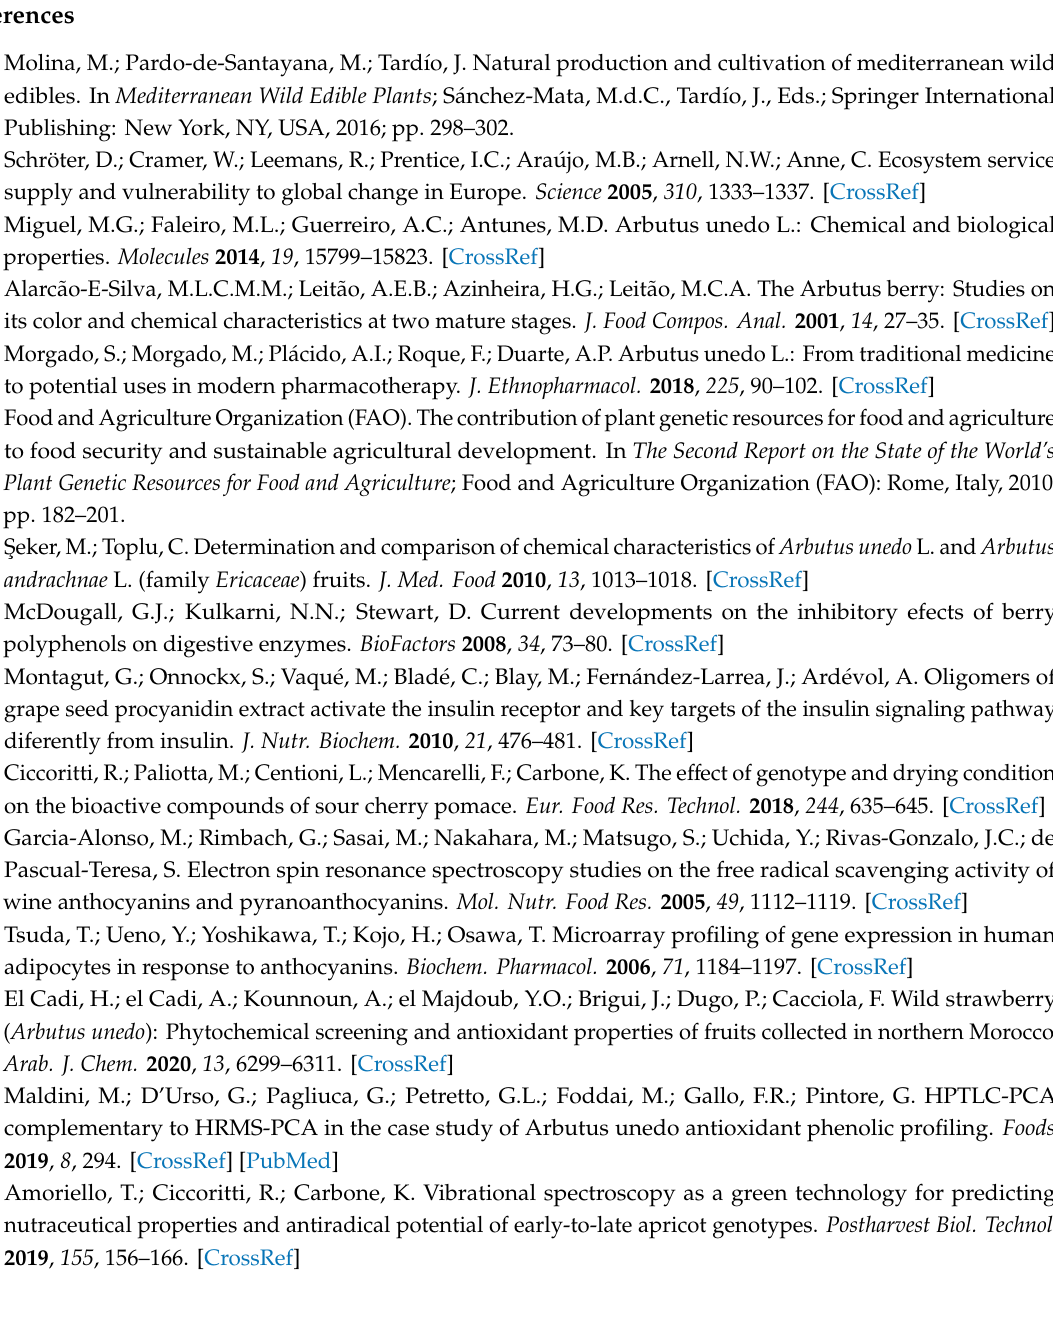
Table S1: Spectral features of A. unedo wild berries